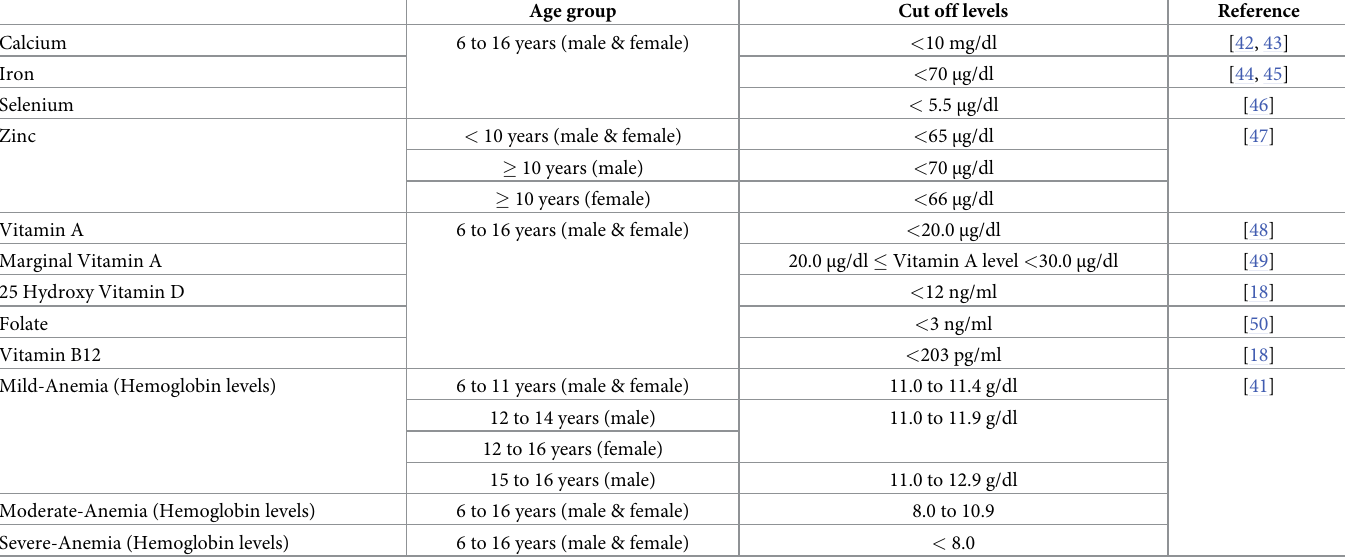
Table 1. Deficiency cut off levels of micronutrients and